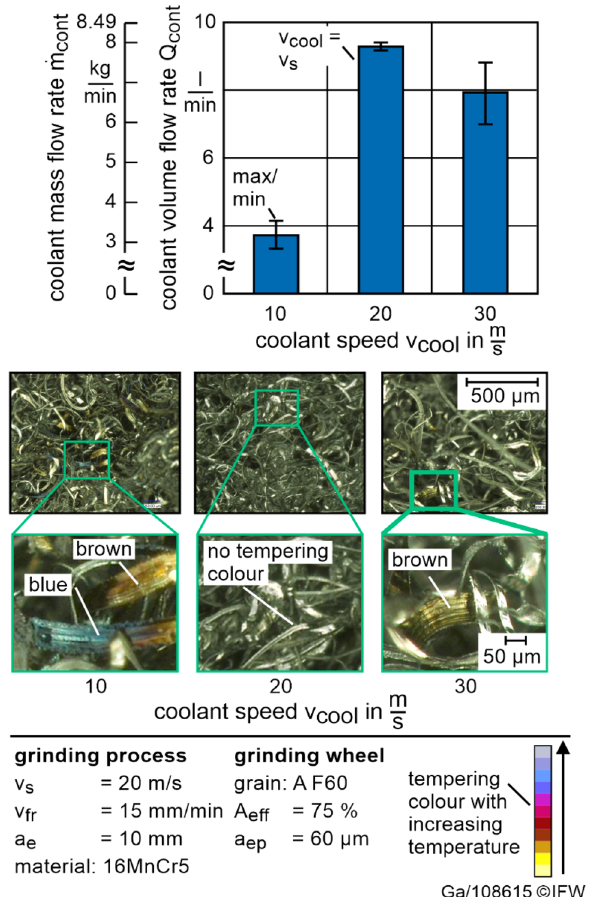
Fig. 11 Influence of the coolant velocity on the resulting coolant flow rate through the contact zone with according